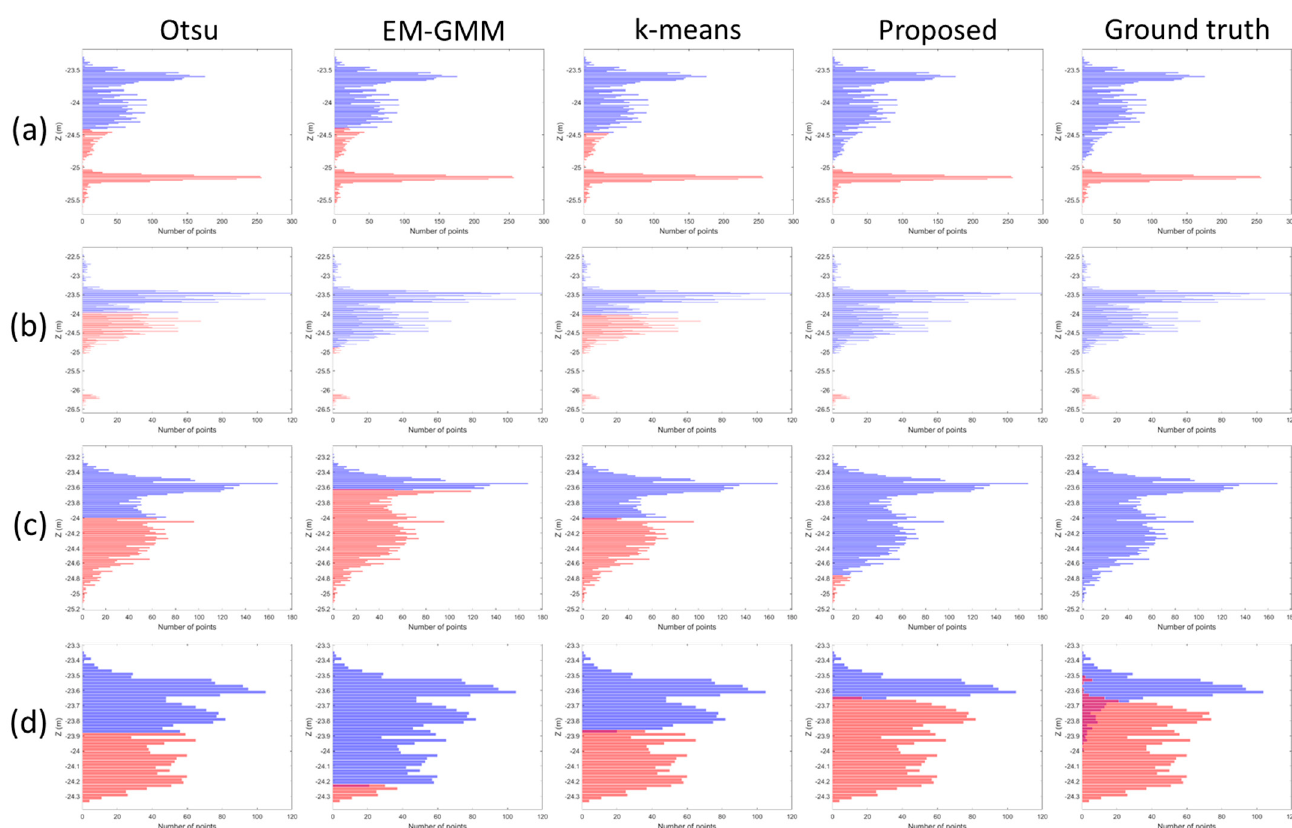
Figure 8. Example histograms showing segmented seafloor (red) and non-seafloor (blue) segments of Marco datasets with cell number: ( a ) 4–149; ( b ) 3–6; ( c ) 3–52; and ( d ) 5–148. All the example datasets are in NAD88 height.